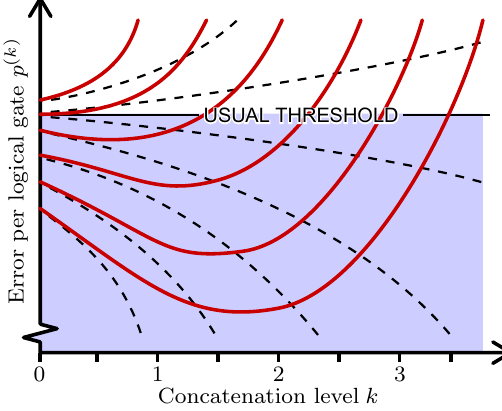
FIG. 3. The black dotted curves are a schematic of the con- ventional situation, where the physical error probability η is independent of the scale—the concatenation level k — of the computer. The red solid curves are a schematic of the consid- eration in this work, where η grows with k (each red curve is for a different value of p ( 0 ) ≡ η ). If η is k independent, standard FTQC analysis says that the error per logical gate p ( k ) can be brought as close to 0 as desired by increasing k , provided that one starts below the threshold (solid horizontal line) at k = 0. If η depends on k , even if one starts below the threshold, p ( k ) eventually turns around for large enough k . p ( k ) cannot reach 0; there is a maximum concatenation level and a further increase in k only increases the logical error. All examples in this work have at most one minimum in each red curve but, in general, there can be multiple